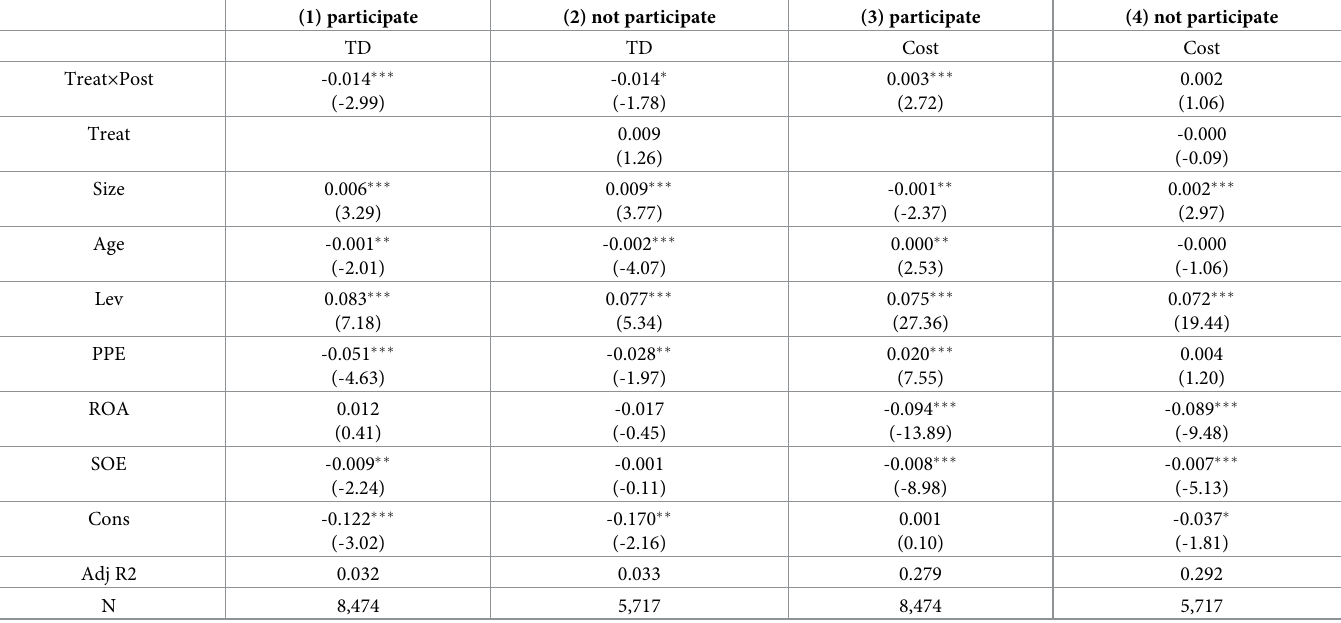
Table 6. Impacts of institutional